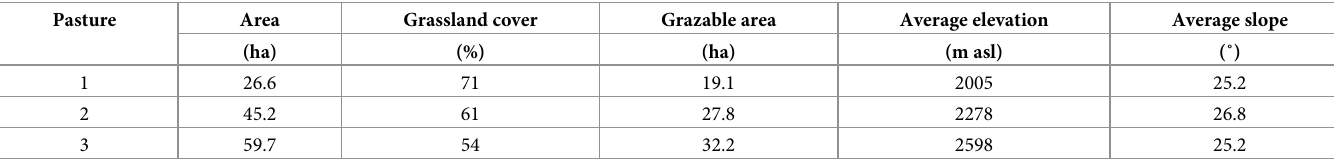
Table 1. Characteristics of the three pastures located at Val Troncea Natural Park (Italy) and used for the farm-scale study. Pasture Area Grassland cover Grazable area Average elevation Average slope (ha) (%) (ha) (m asl)